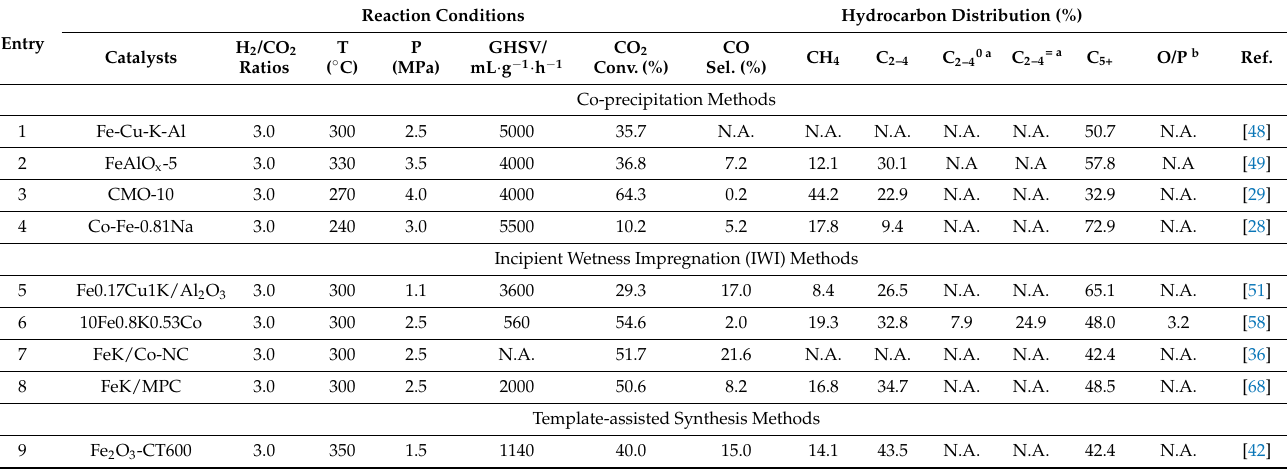
Table 3. Representative catalysts prepared by different preparation methods and their catalytic performance for CO 2